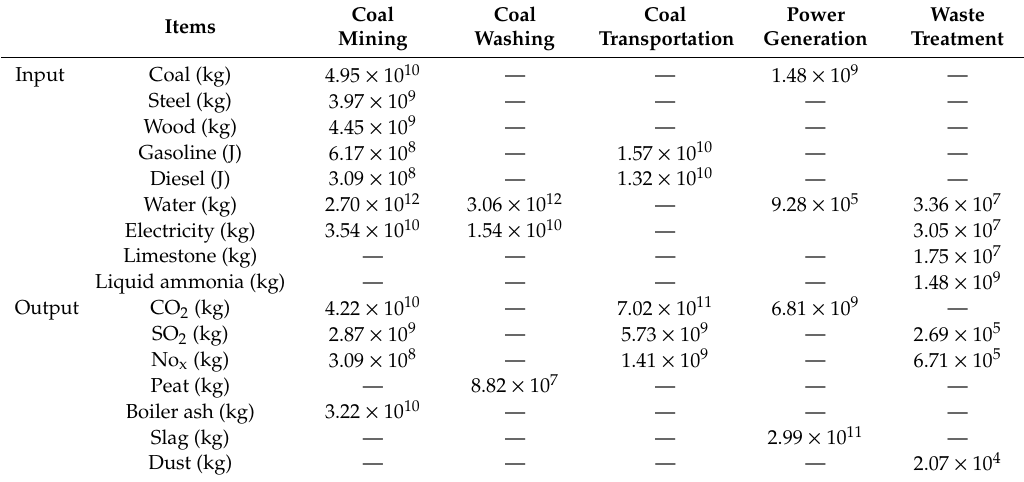
Table 3. Life cycle inventory of a 660 MW coal-fired generating unit (Unit 3). Items